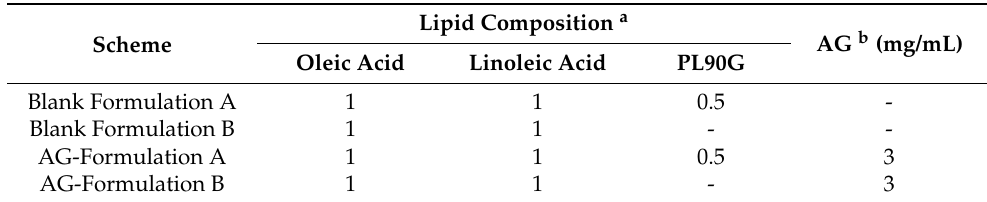
Table 1. Lipid composition of unsaturated fatty acid